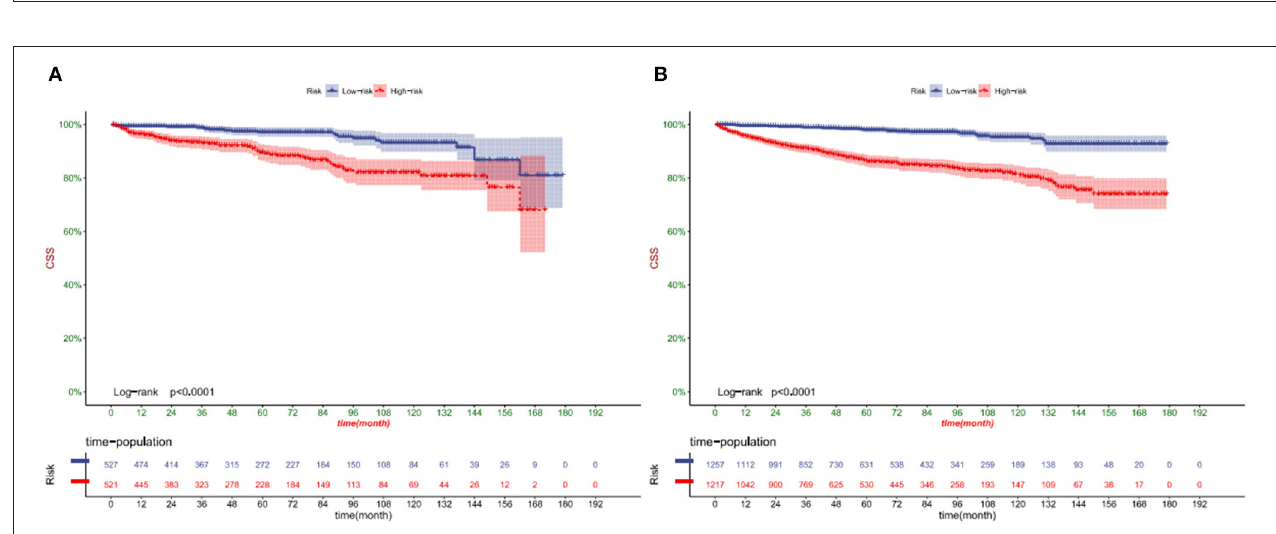
FIGURE 6 | Kaplan-Meier curves of patients in the low-risk and high-risk groups in training cohort (A) and validation cohort (B) .